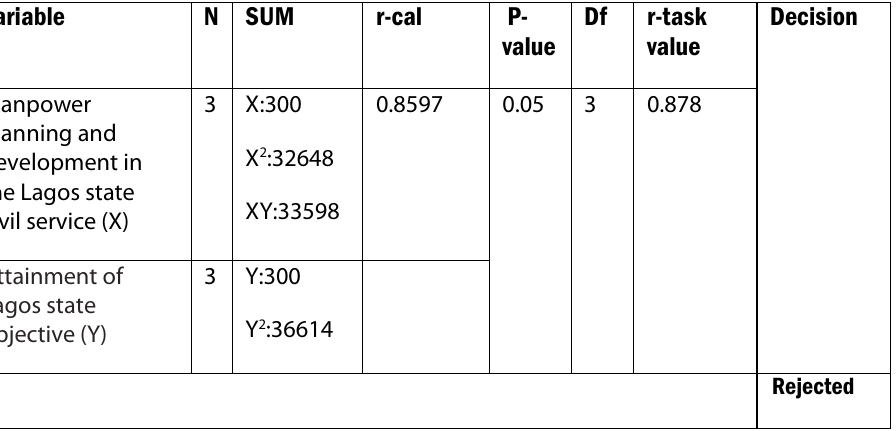
Table 1: Manpower planning and development and attainment of Lagos state objective Variable N SUM r-cal r-task